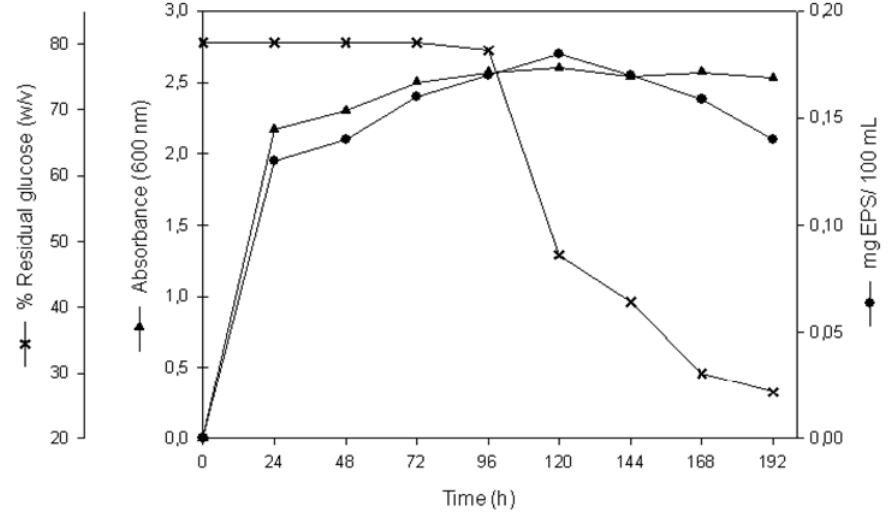
Figure 1. Profile of growth and EPS production by H. almeriensis strain M8 T in MY medium at 7.5% w/v total salts with reference to glucose consumption. ( ▲ ), optical density at 600 nm; ( ● ), g EPS per litre of culture medium; ( x ), % residual